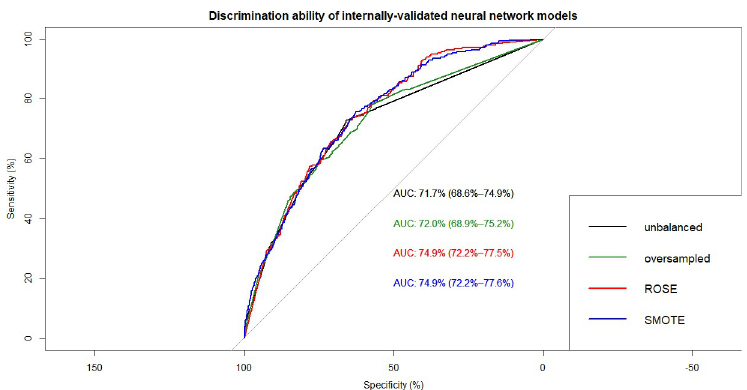
Fig 6. Overlapped ROC curves demonstrating predictive performance of artificial neural network models on internal validation data. Using unbalanced, original training data and re-structured with oversampling, ROSE and SMOTE